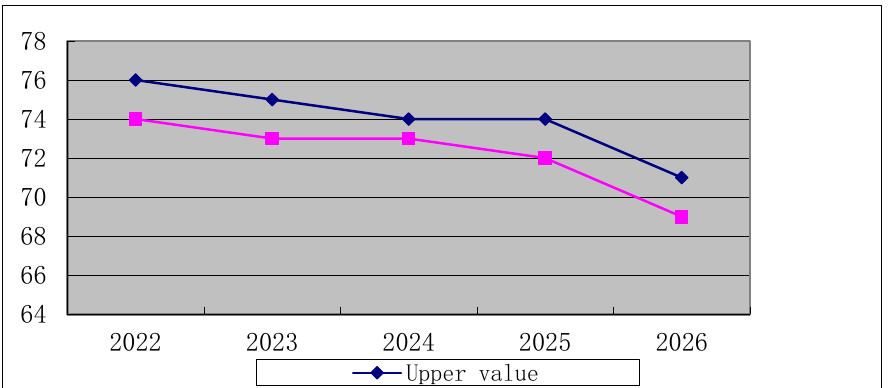
Figure 16. The variation interval of water requirement with the influence of the tertiary industry in Shanxi Province.